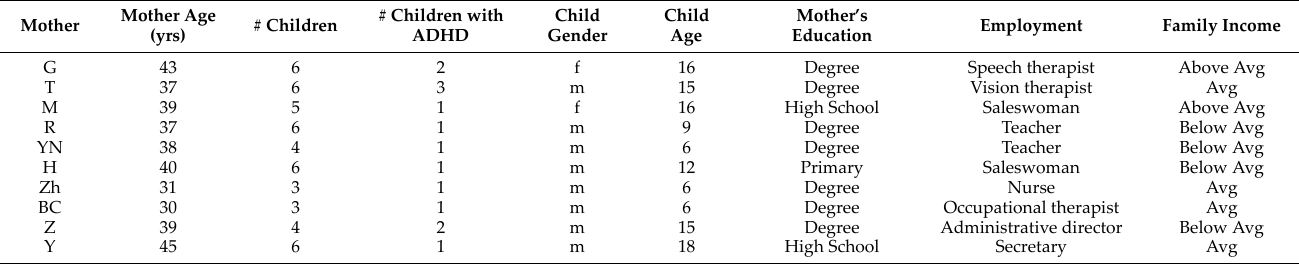
Table 1. Socio‑demographics of participants ( n = 10).